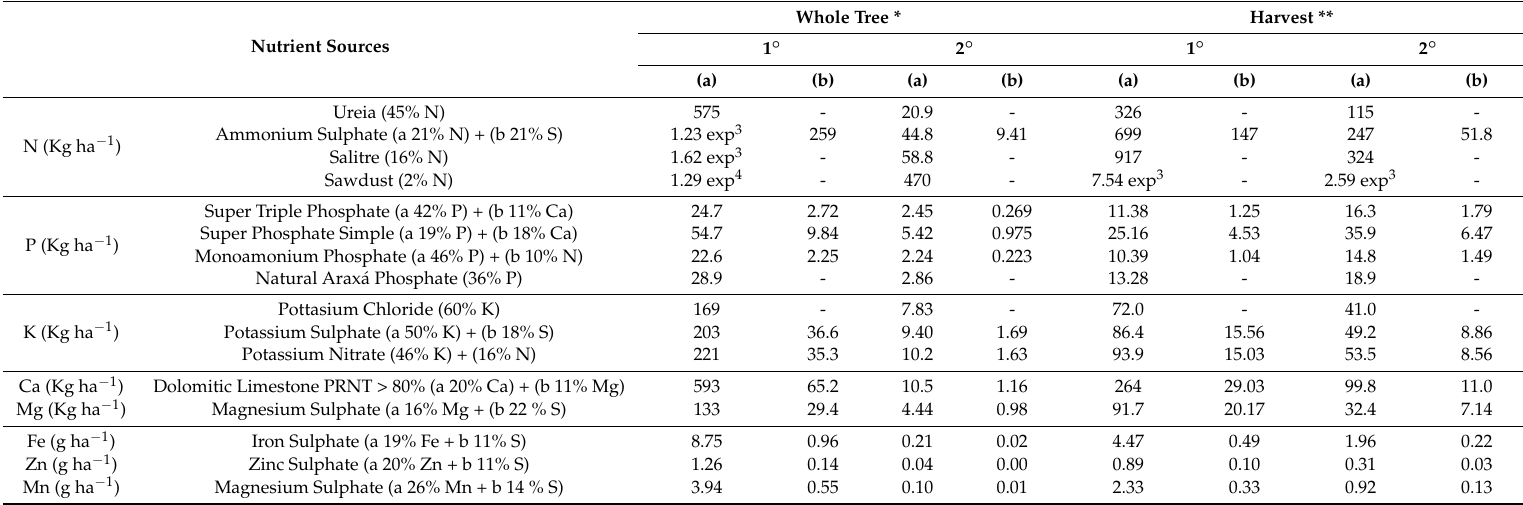
Table 2. Sources and doses of macro- and micronutrients available in the Amazon region, suggested for nutritional replacement of rosewood plantations, based on the quantities exported by above ground biomass crops in commercial plantations of Central